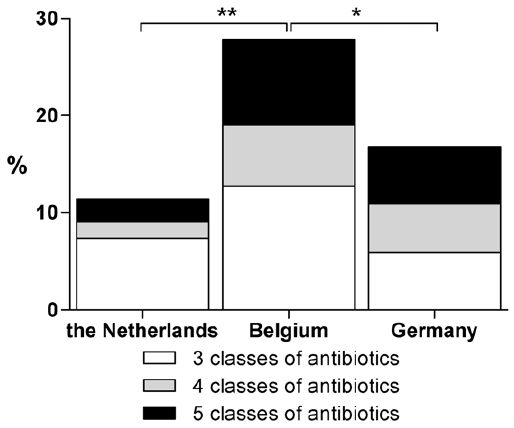
Figure 1. Prevalence of multi drug resistance of E.Coli. * = p , 0.05, ** = p , =0.001.